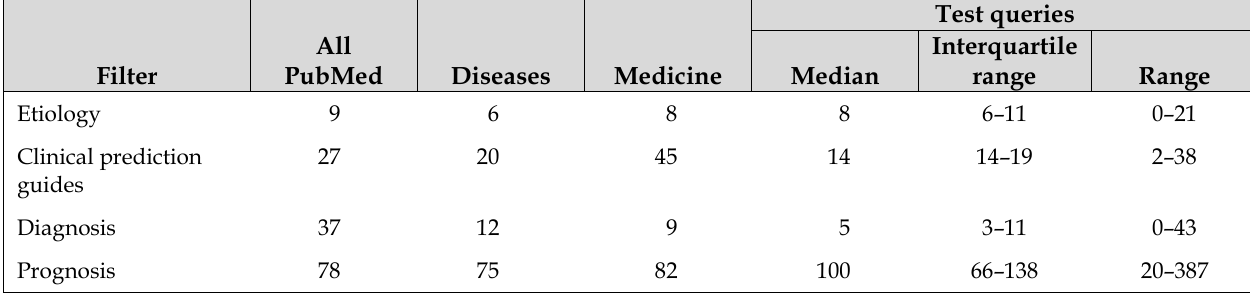
Table 3 Filter /Narrow citations missed per 1,000 Filter /Broad when searching Broad alone